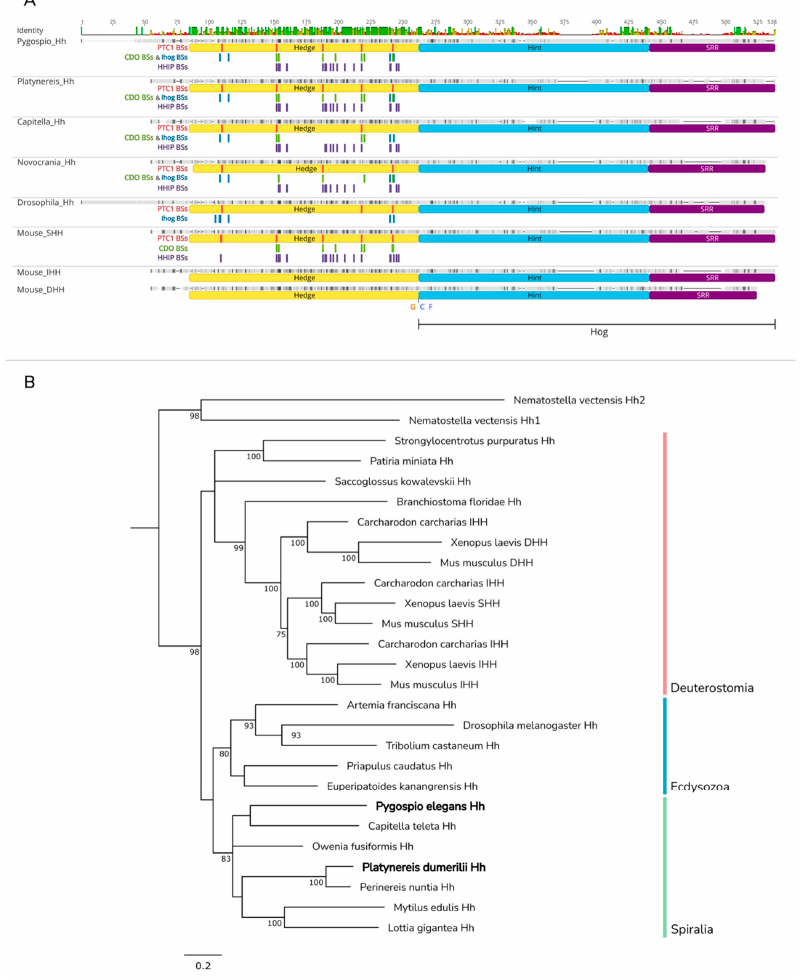
Figure 2. Multiple sequence alignment and phylogenetic analysis of Hh proteins. ( A ) All Hh proteins include an N-terminal Hedge domain and a C-terminal Hog domain. Comparison of Hedge domains from spiralians, Drosophila , and mouse revealed that Pygospio and Platynereis Hh ligands have the sites that are essential for interaction with Patched (indicated by red bars), Ihog (indicated by blue bars), CDO (indicated by green bars), and HHIP (indicated by violet bars). Pygospio and Platynereis Hedge domains are more similar to murine Hh-Hedge (71.9% and 81.9% similarity, respectively) than to Drosophila Hh-Hedge (58.9% and 73.5% similarity, respectively). SRR, sterol-recognition region; PTC1 BSs, Patched-binding sites; CDO BSs, CDO-binding sites; IHOG BSs, IHOG-binding sites; HHIP BSs, HHIP-binding sites. ( B ) Bayesian phylogenetic analysis was performed on Hh protein sequences including Hedge and Hog domains. Hh1 and Hh2 from Nematostella were used as an outgroup, as later it was shown that Nv-Hh1 and Nv-Hh2 form a sister group to each other and together are sisters to bilaterian Hh proteins [5]. Numbers near branch nodes indicate Bayesian posterior probabilities. Bayesian posterior probability values less than 75 are not